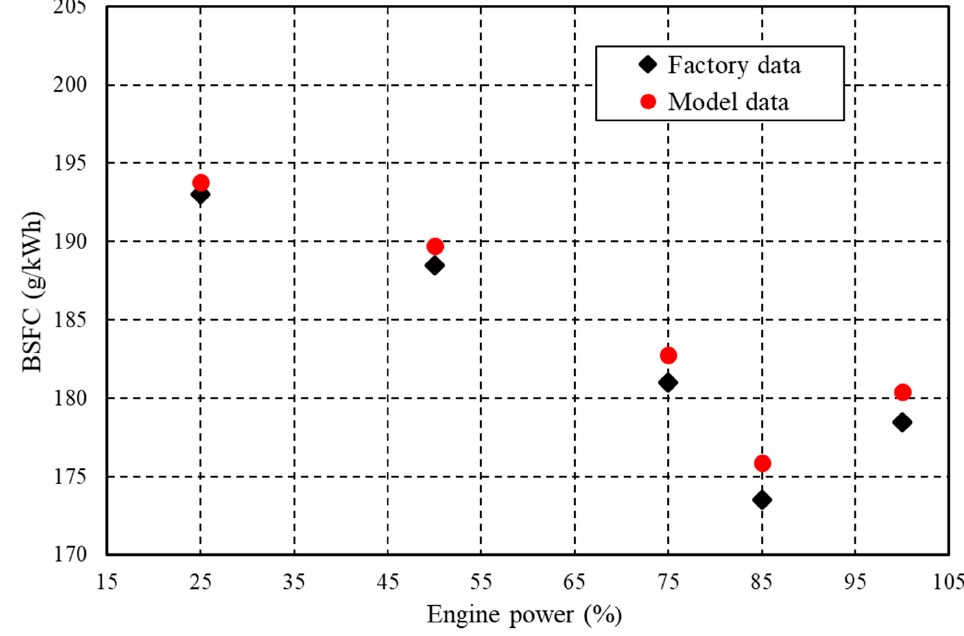
Figure 11. Speci fi c fuel consumption of the MAN 18V32/44CR diesel engine in the range from 25% to 100%